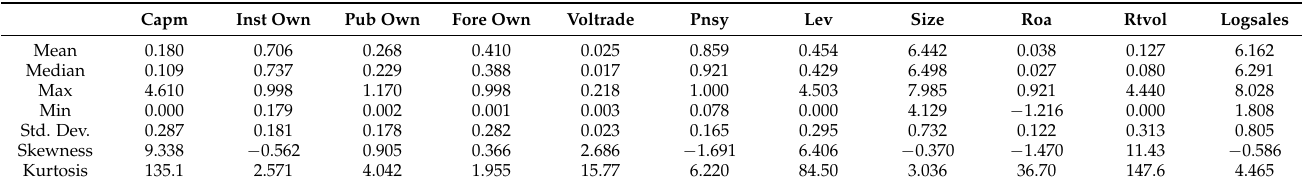
Table 2. Descriptive Statistics.